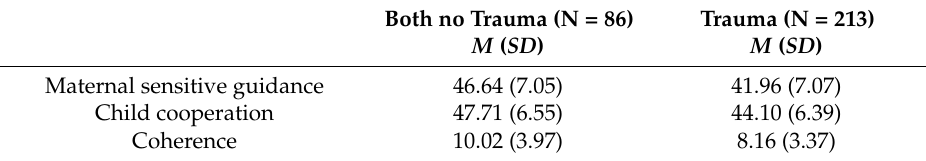
Table 4. Quality of mother-child interaction in samples with and without trauma